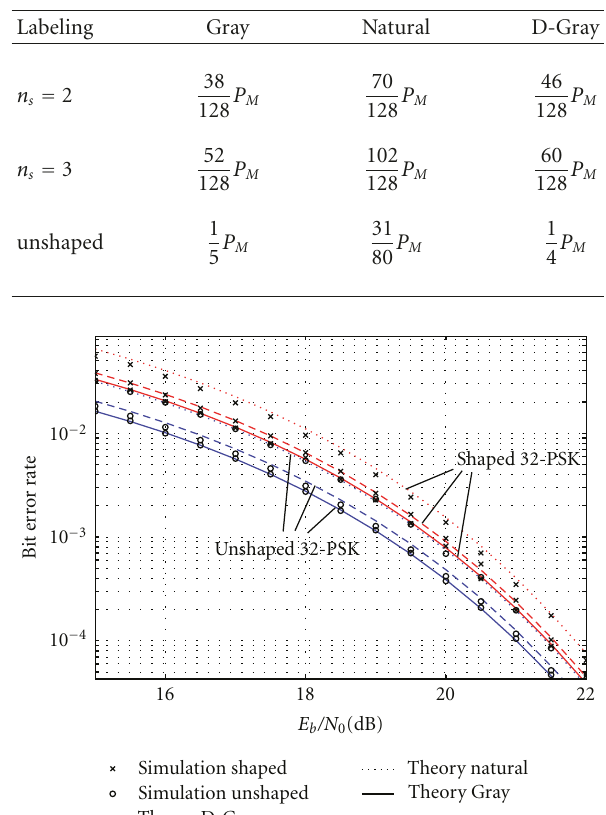
Table 3: Average BER expressions of unshaped and trellis shaped 32-PSK systems with respect to the symbol error rate P M . (For unshaped system with D-Gray labeling, n s = 3 is used for calculation.)